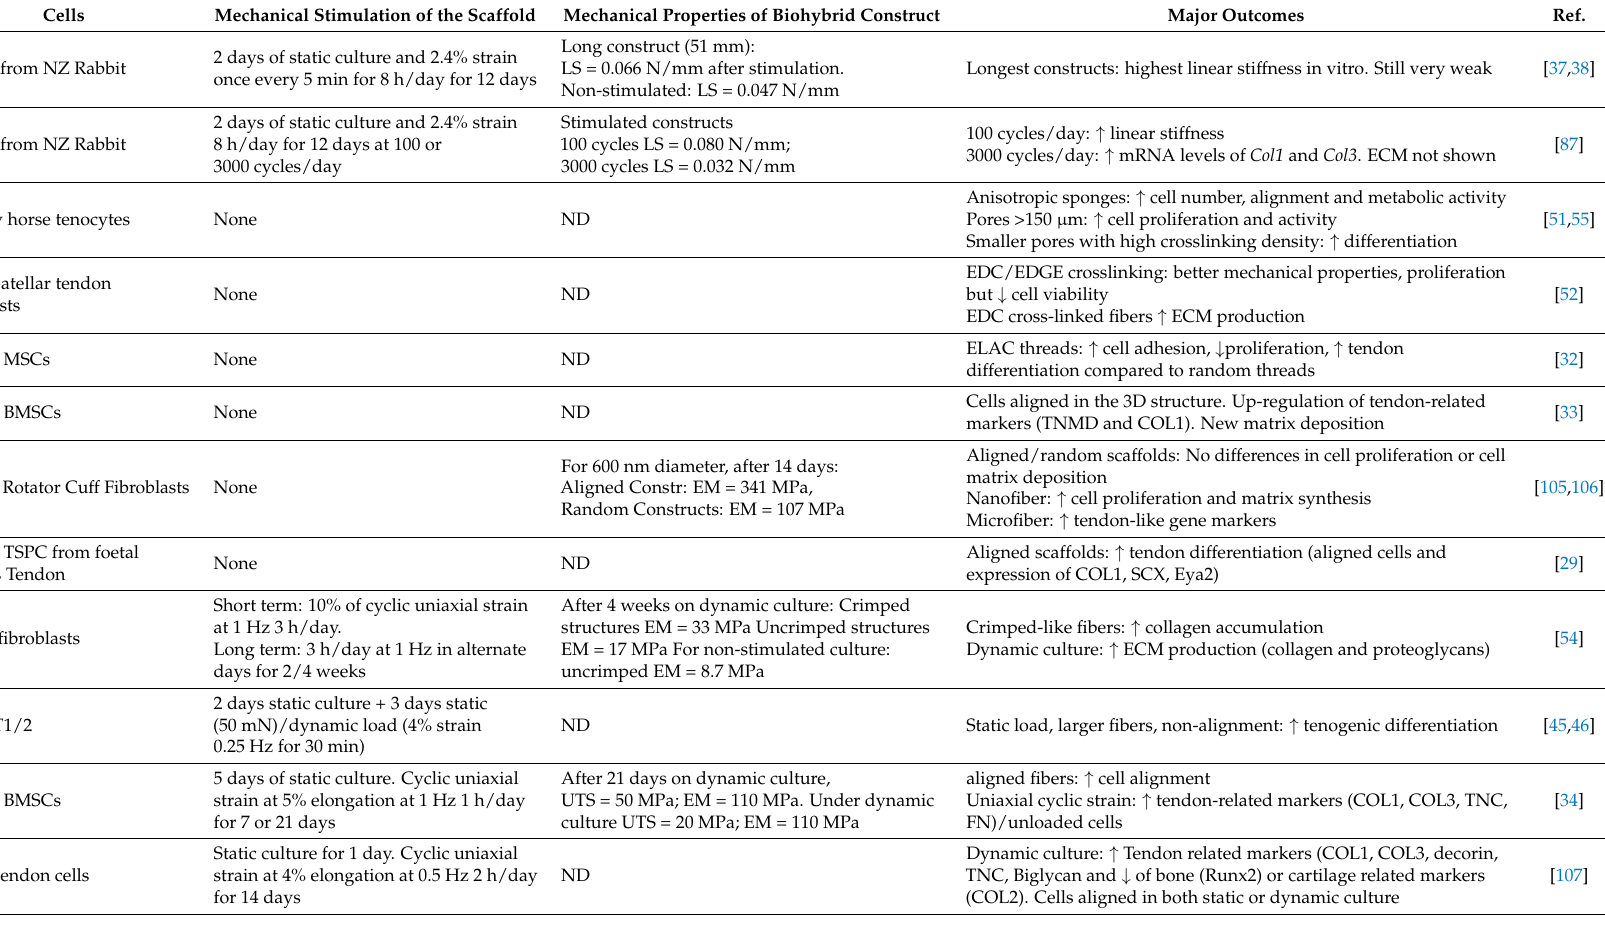
Table 2. In vitro performances of biohybrid scaffold in tendon tissue engineering ( ↑ = increase, ↓ = decreases). Cells Mechanical Stimulation of the Scaffold Mechanical Properties of Biohybrid Construct Major Outcomes